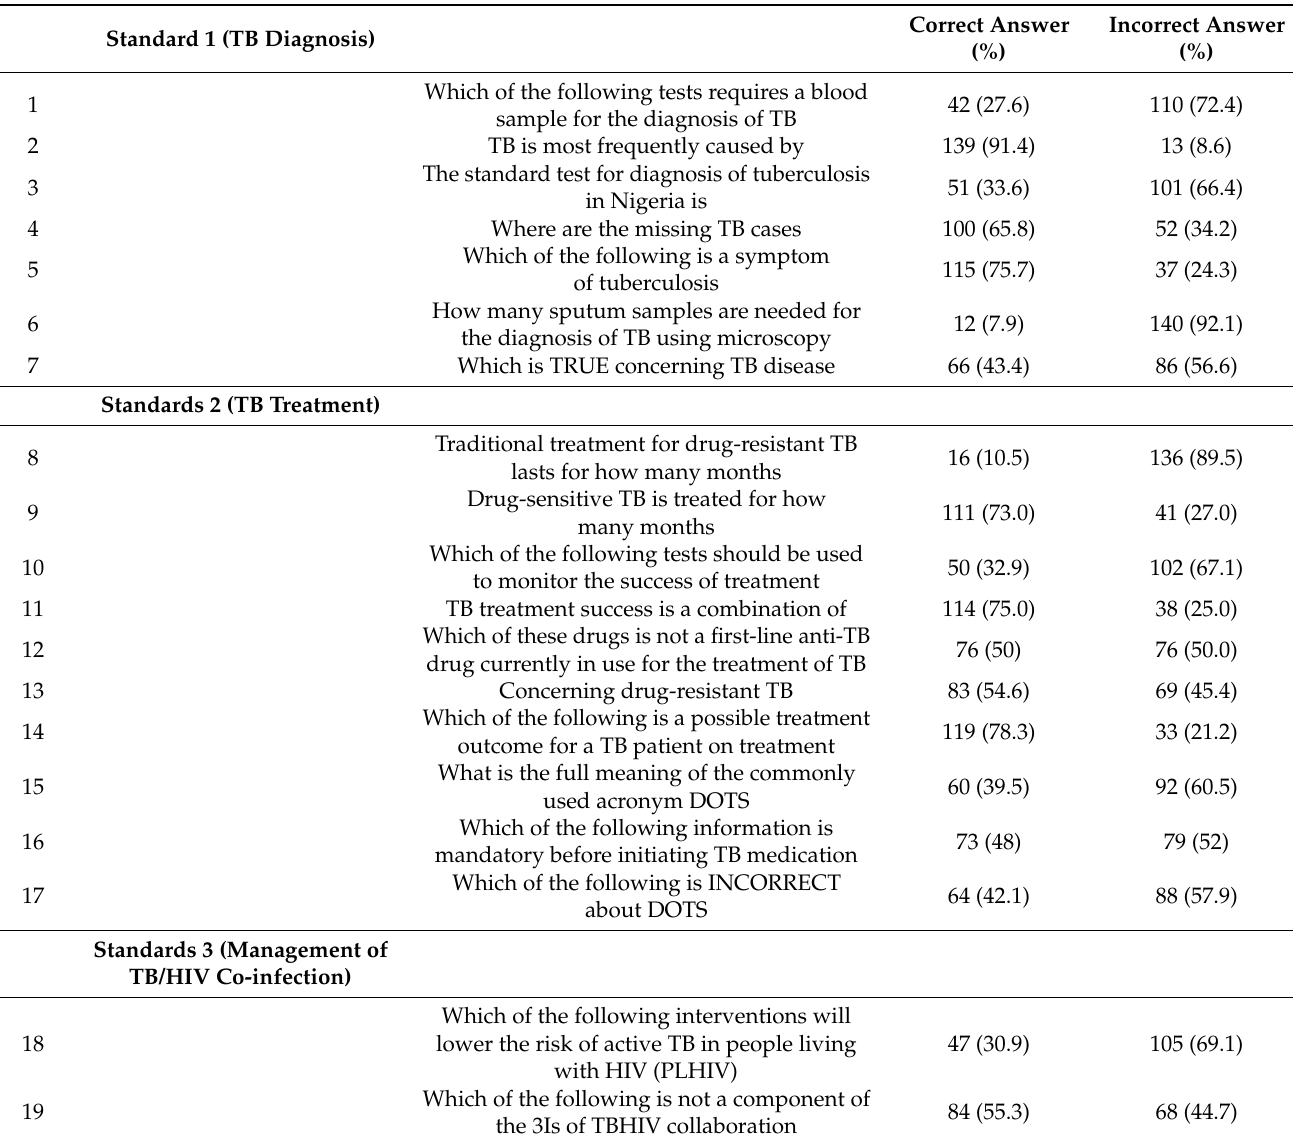
Table 2. Participants’ responses to questions assessing knowledge of tuberculosis diagnosis, treatment, TB/HIV co-infection, public health and patient